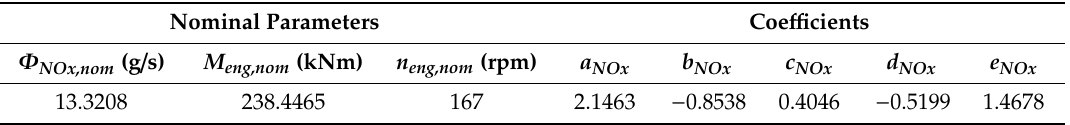
Table A1. Coe ffi cients of NOx emission model of main engine.